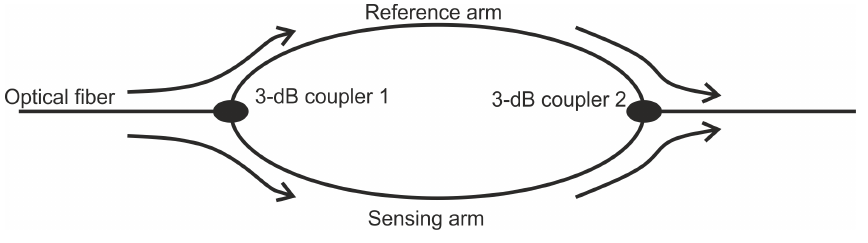
Figure 5. Principle of MZI (based on reference [49]).